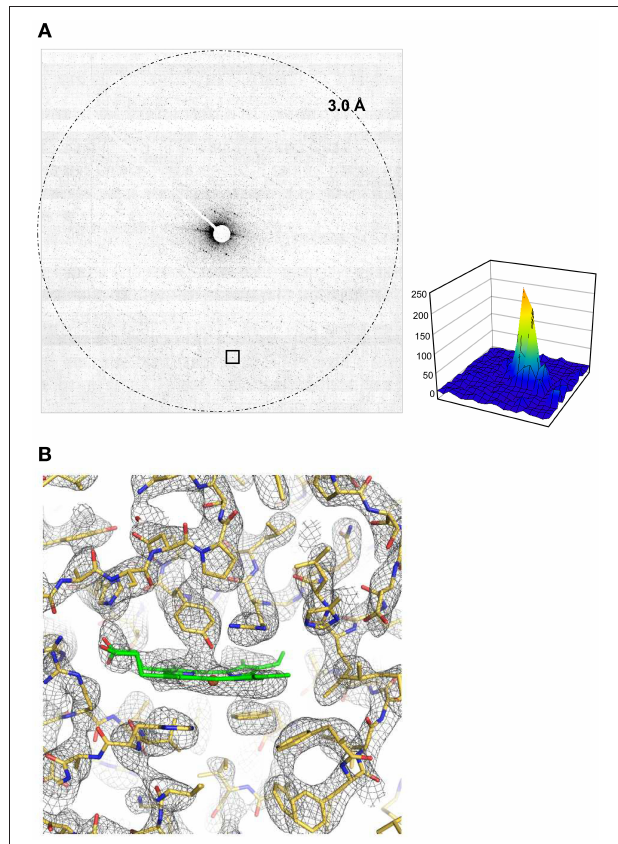
FIGURE 3 | Structure analysis of catalase. (A) One frame covering a rotation of 0.5 ◦ at 0.005 e − /Å 2 for 0.25s exposure. An intensity profile in 19 × 19 pixels is shown on the right side for a diffraction spot at 4.3 Å resolution enclosed with a square at the bottom. (B) A Coulomb potential map ( σ A -weighted 2 | F obs | – | F calc | maps) of catalase around the heme-binding site overlaid with the atomic model refined in this study. Calculated from the full rotational frames. The asymmetric unit of the crystal contains one tetramer of catalase, and non-crystallographic symmetry averaging was applied to the four molecules. Gray nets are contoured at 1.3 σ , and carbon atoms in the model of heme is in